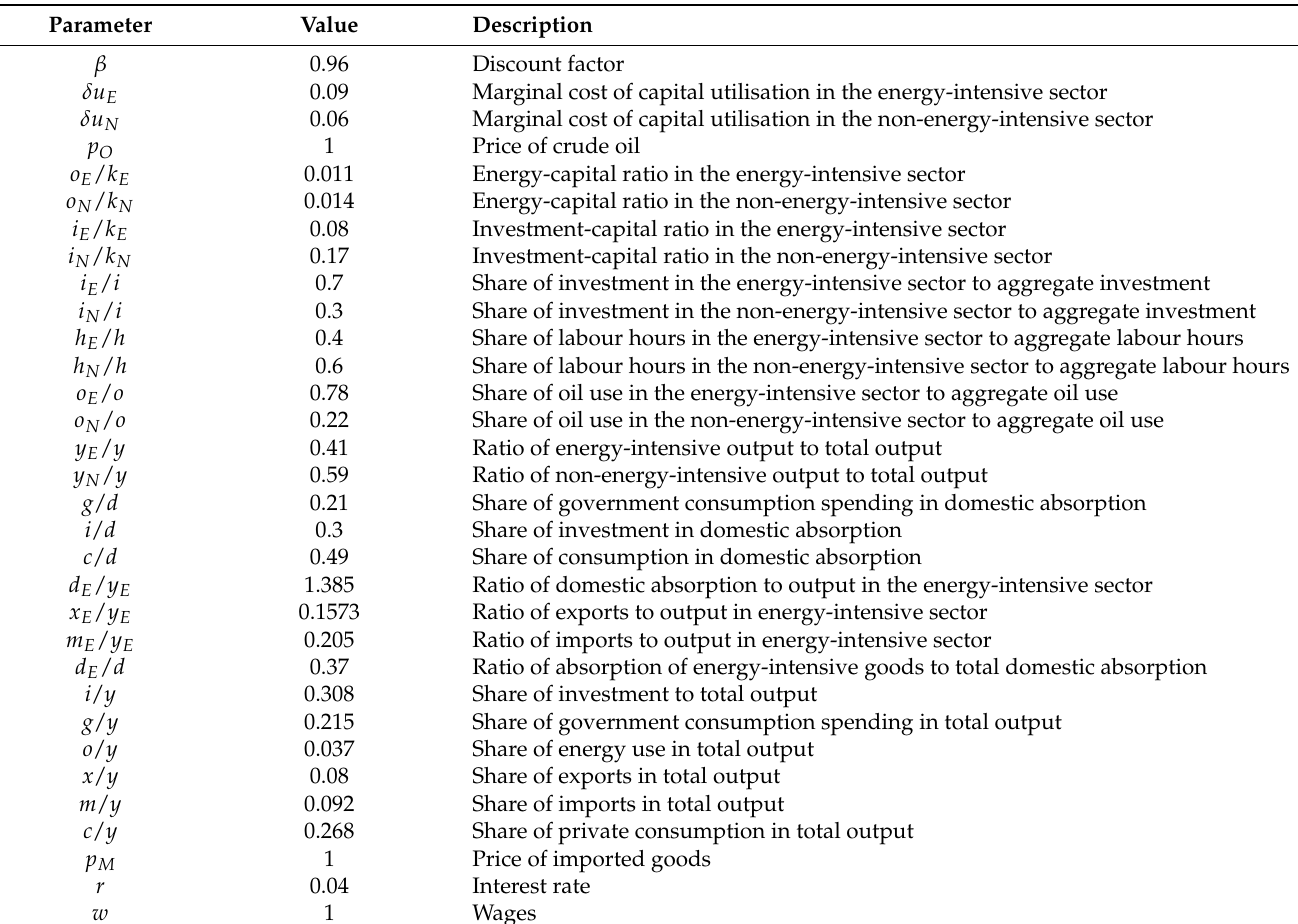
Table A2. Fixed structural parameter and steady state